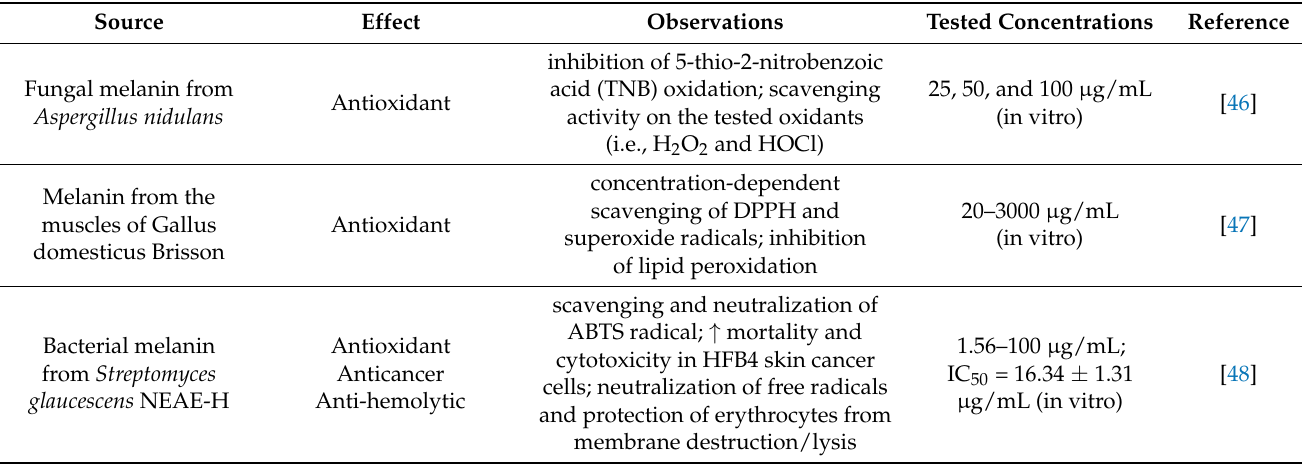
Table 1. Relevant studies highlighting the therapeutic properties exerted by melanins from differ- ent